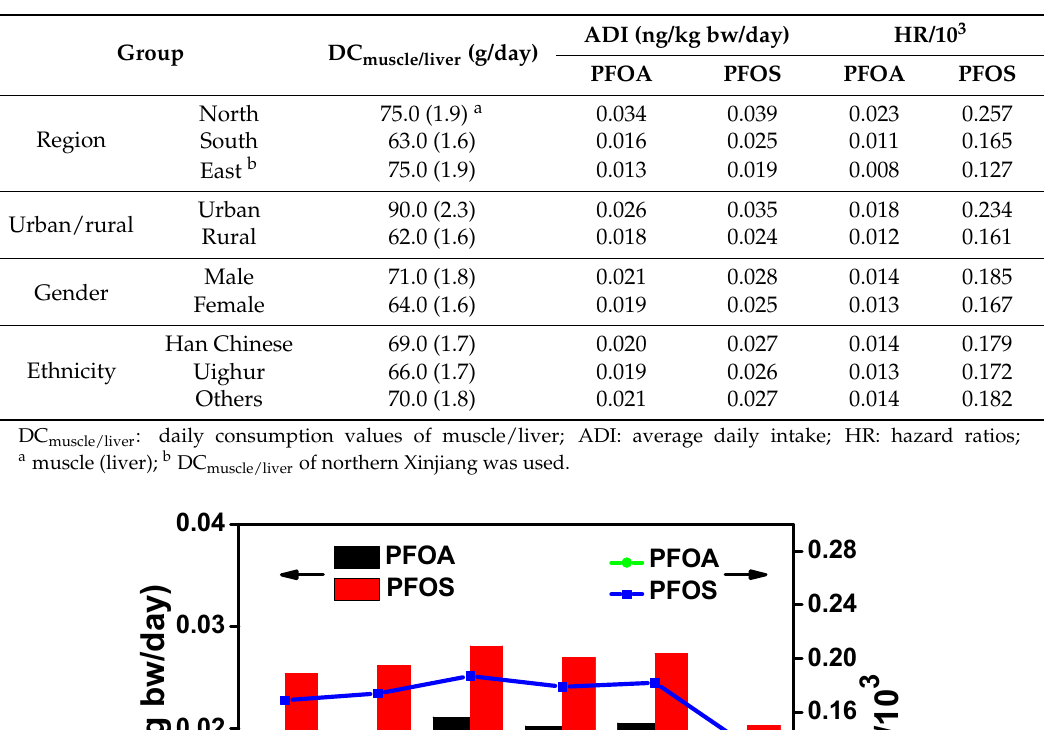
Table 2. The consumption data, average daily intake, and hazard ratios of PFOS and PFOA for various groups (region, urban/rural, gender, and ethnicity).